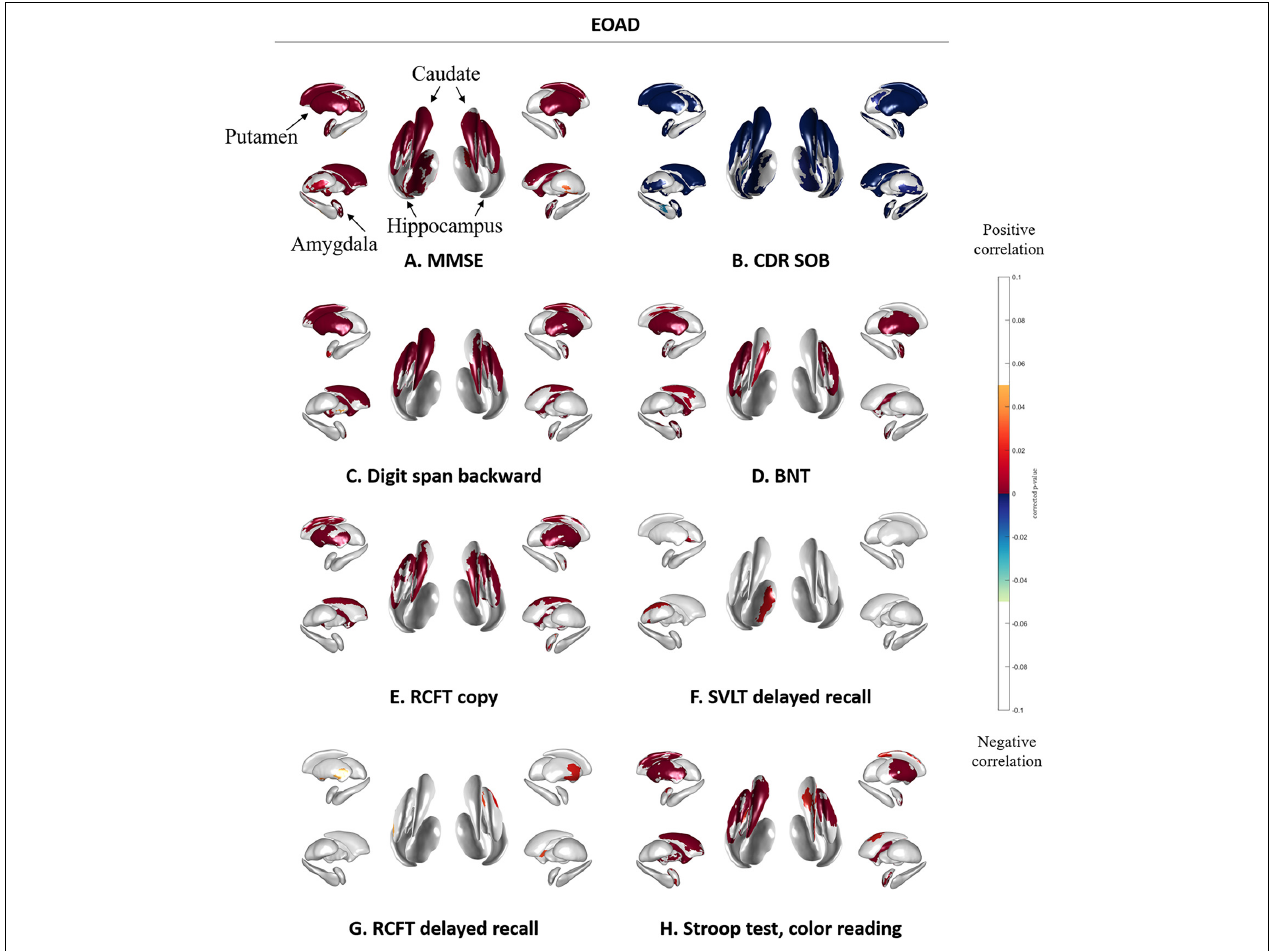
FIGURE 3 | Spearman correlation between neuropsychological test results and subcortical local shape in EOAD group adjusted with intracranial volume. (A) MMSE, (B) CDR-SOB, (C) digit span backward score in attention, (D) BNT score in language, (E) RCFT copy score in visuospatial, (F) SVLT delayed recall score in memory, (G) RCFT delayed recall score in memory, and (H) color reading test score in frontal/executive function. The mapped p -values are multiple corrected using cluster-based statistics. Abbreviations: EOAD, early onset Alzheimer’s disease; MMSE, mini-mental state examination; CDR-SOB, clinical dementia rating-sum of